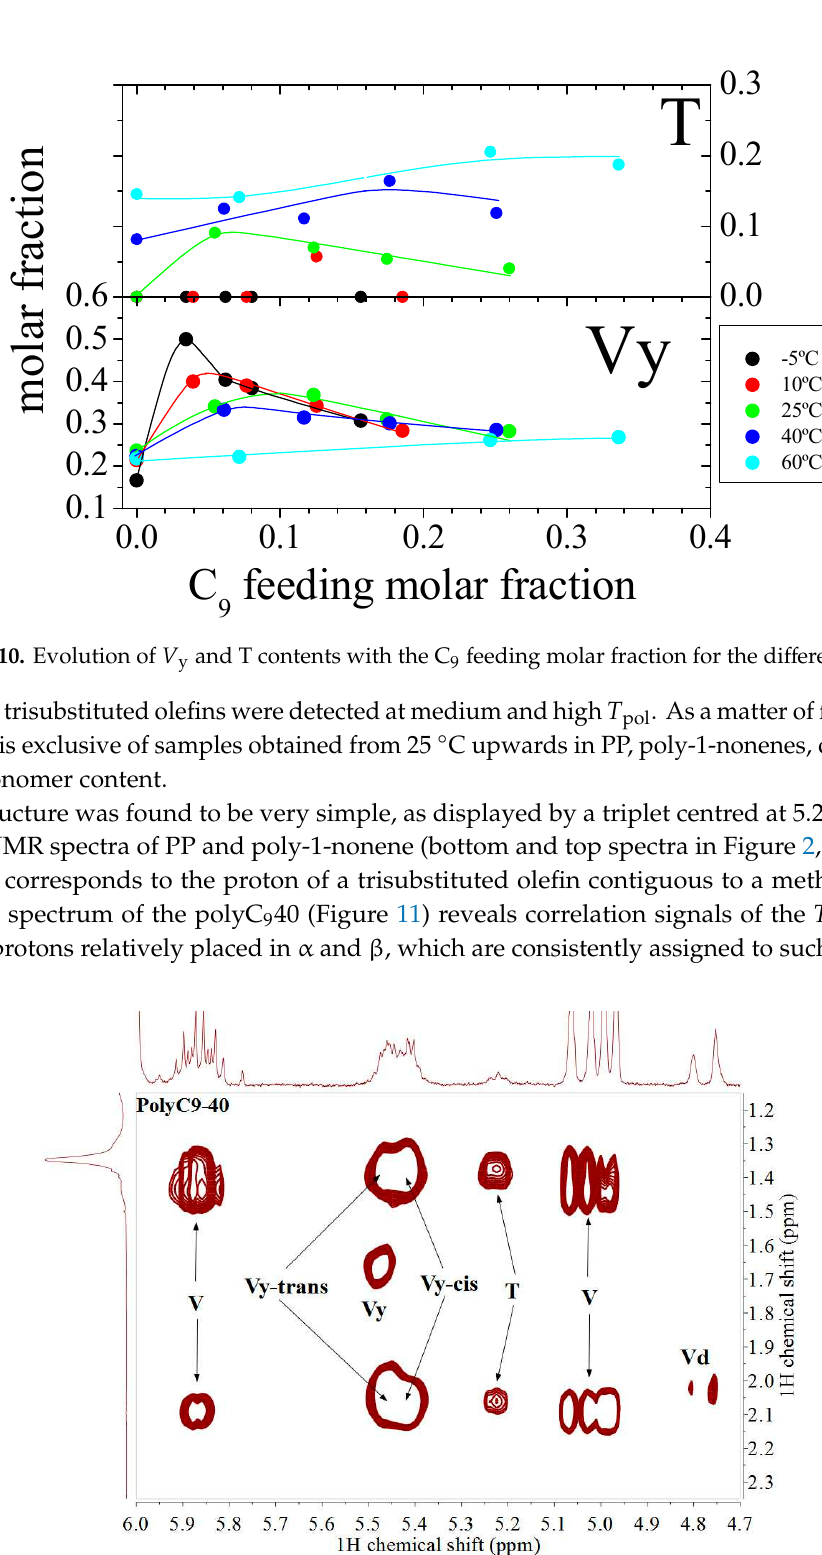
Figure 11. 1 H- 1 H TOCSY map of the sample polyC 9 40.